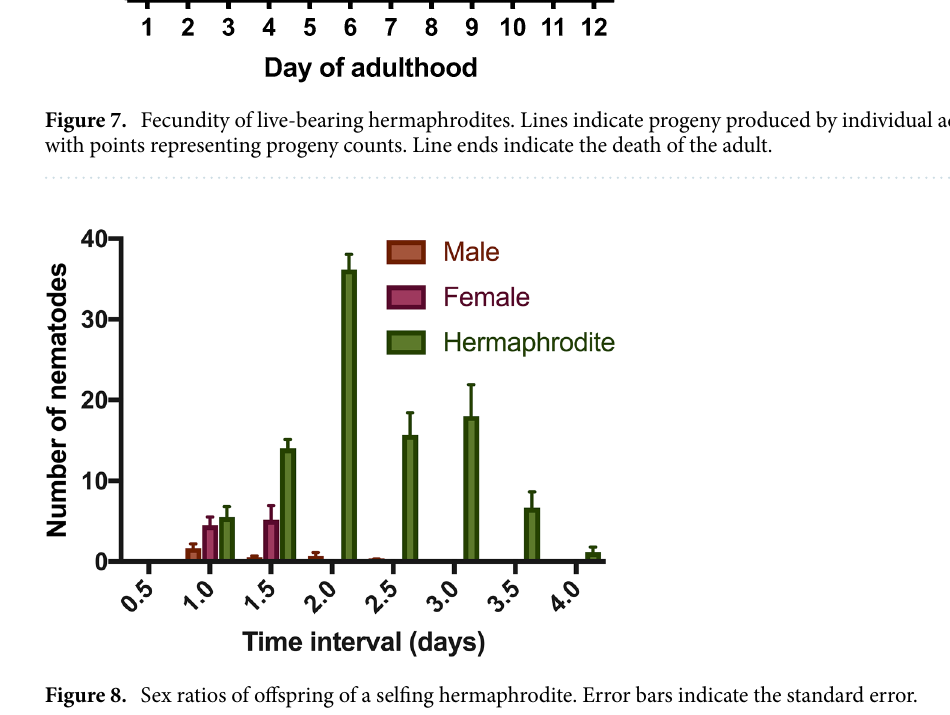
Figure 8. Sex ratios of offspring of a selfing hermaphrodite. Error bars indicate the standard